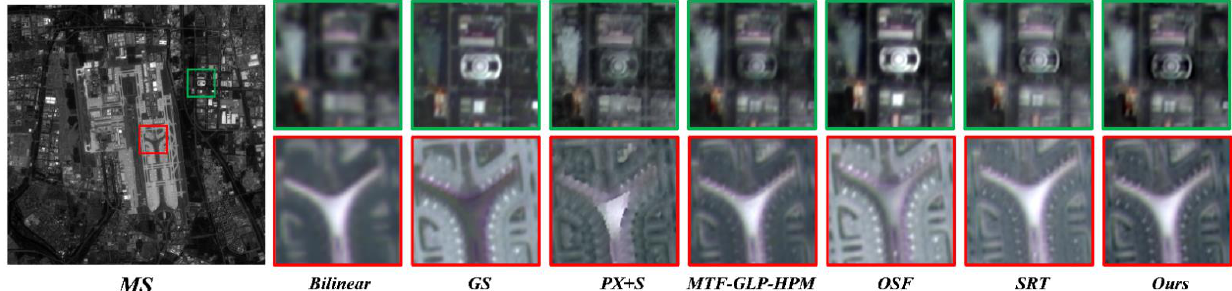
Figure 8. The results of different fusion methods for Beijing Capital International Airport are shown.